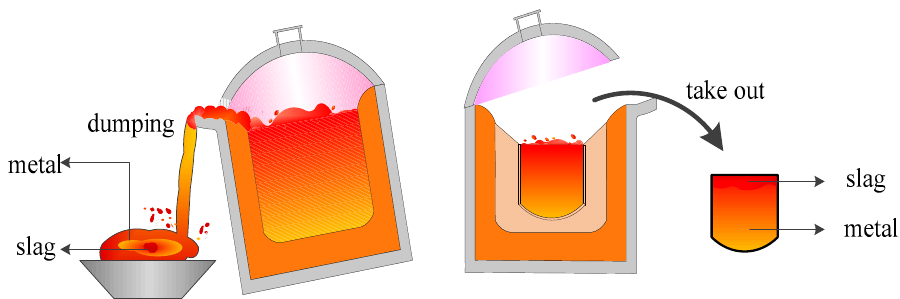
Figure 6. Comparison of metal and slag separation effects.